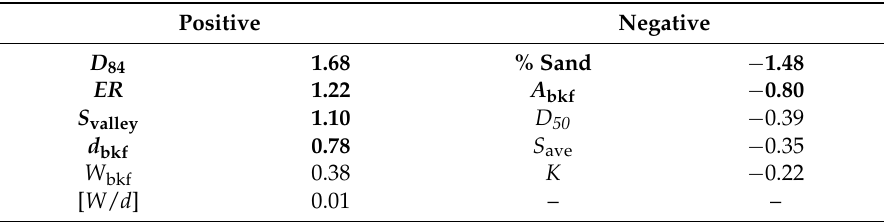
Table 6. Coefficients or weights for each morphology factor (design and landscape) resulting from ridge regression. Variables with higher weights are in bold.